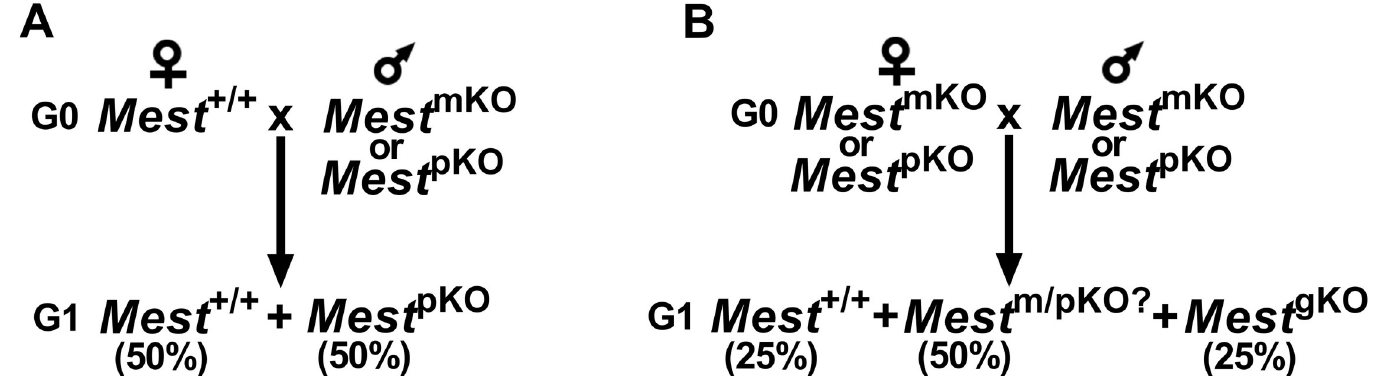
Fig 1. Breeding strategy. Breeding schemes to generate Mest pKO (a) and Mest gKO (b) mice.